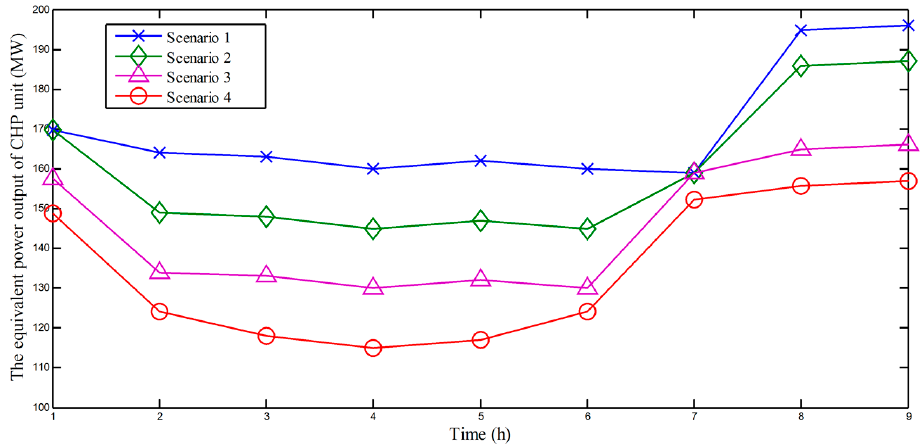
Figure 9. The equivalent power output of CHP unit in off ‐ peak period.